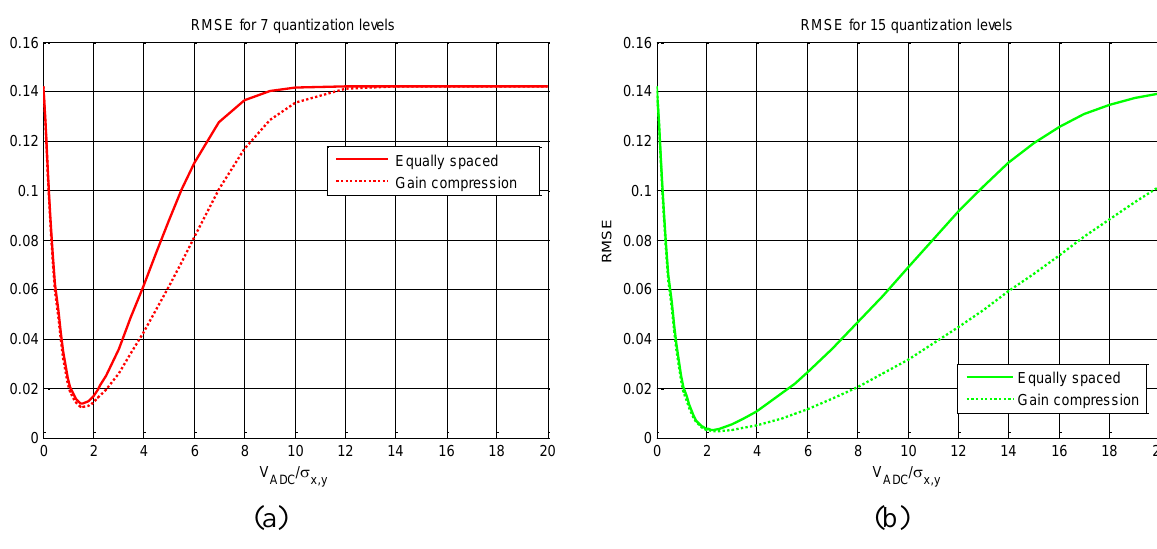
Figure 5. Root mean square error for different levels and different spaced quantification levels, (a) 7 quantization levels, and (b) 15 quantization